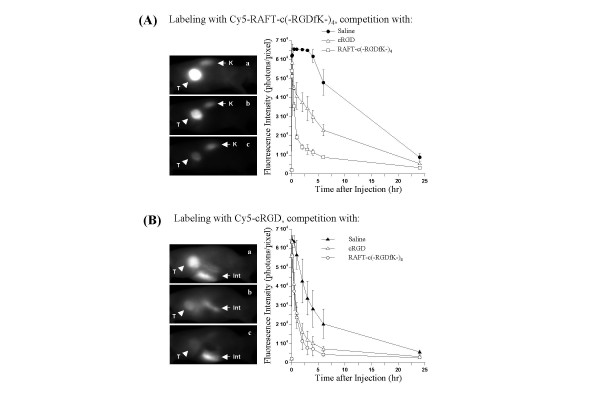
Blocking of Cy5-labeled RGD peptide accumulation in HEK293(β3) s.c. tumors by coinjection with unlabeled RGD peptide. (A) Tumor-bearing mice received i.v. injection of 10 nmol Cy5-RAFT-c(-RGDfK-)4 alone (a), or coinjected with 1200 nmol cRGD (b) or 300 nmol RAFT-c(-RGDfK-)4 (c). (B) Tumor-bearing mice received i.v. injection of 10 nmol Cy5-cRGD alone (a), or coinjected with 1200 nmol cRGD (b) or 300 nmol RAFT-c(-RGDfK-)4 (c). Left panel: representative fluorescence images at 2 hr p.i.; Right panel: kinetics of fluorescence intensities in tumors. T, K and Int indicate tumor, kidney and intestine, respectively. Data are expressed as means ± SD (n = 2–4).